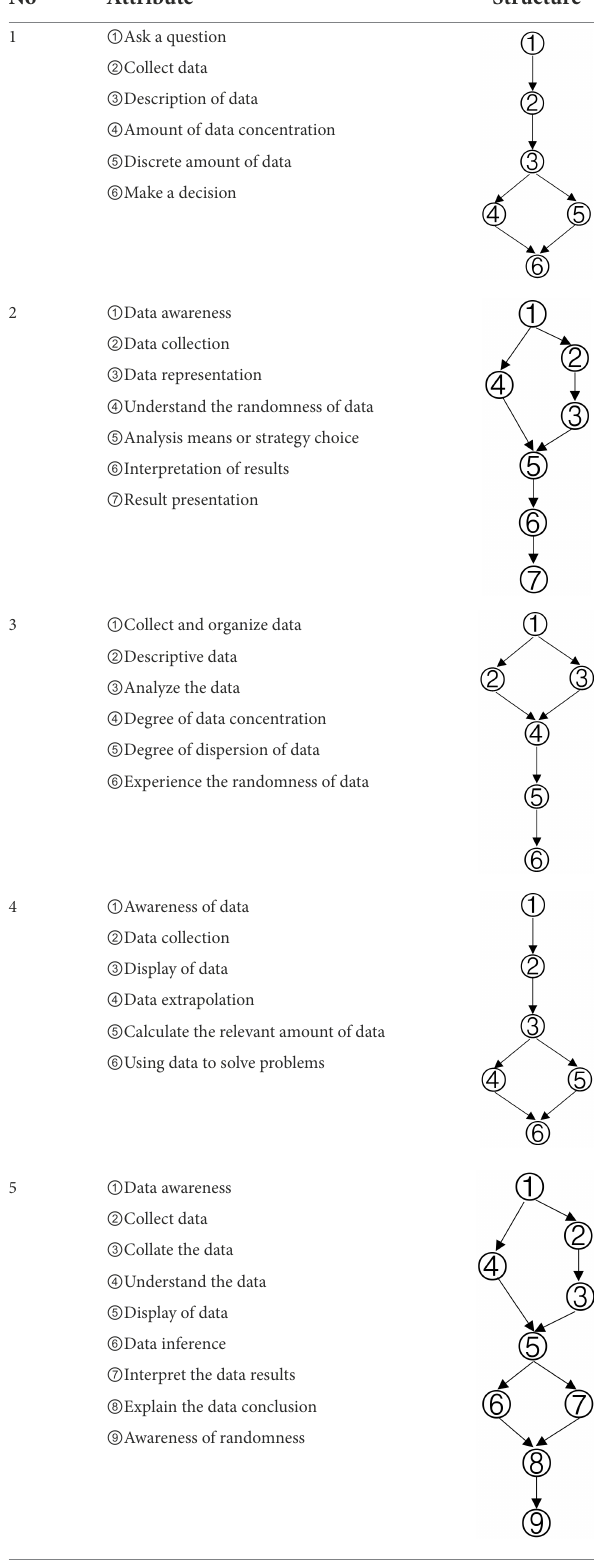
TABLE 1 Analysis of the expert survey of the cognitive model of data analysis ability. No Attribute Structure Common elements